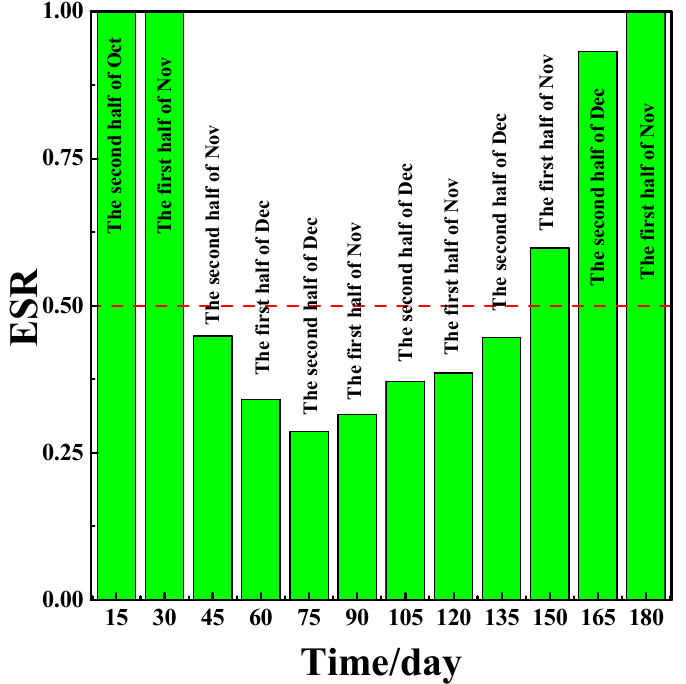
Figure 7. Diagram of energy saving rate over time.